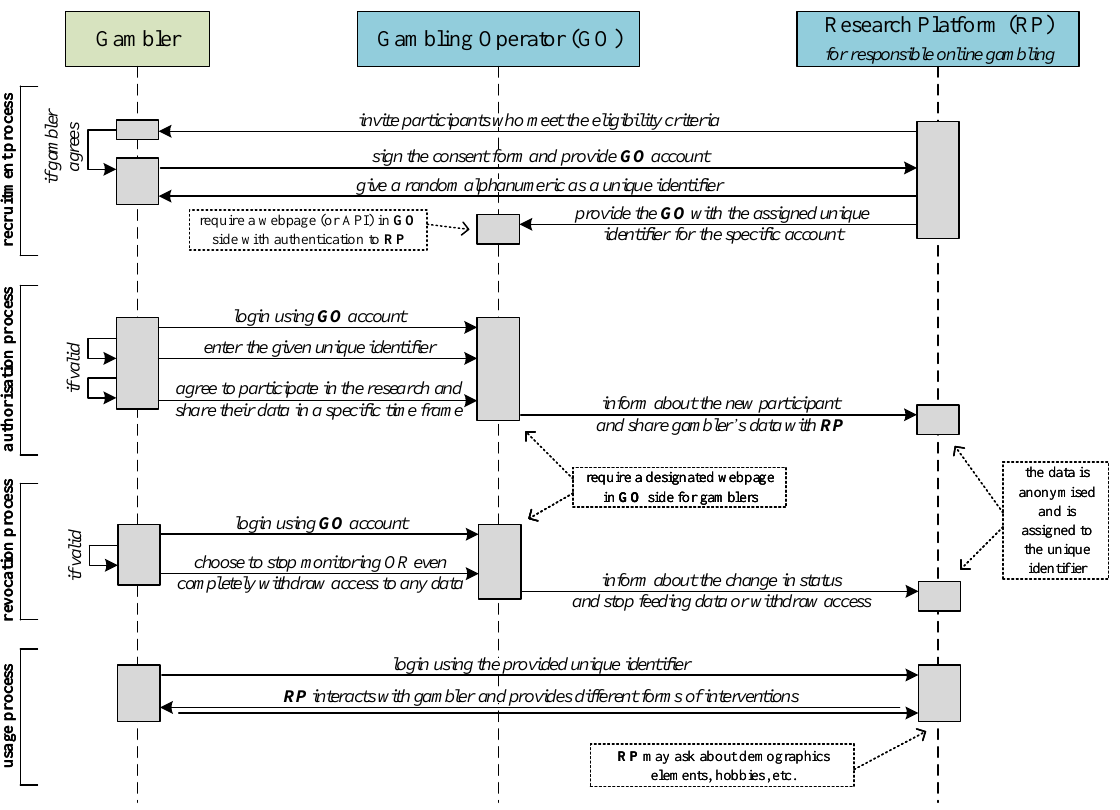
Figure 4. The diagram of a consensus procedure for the gamblers’